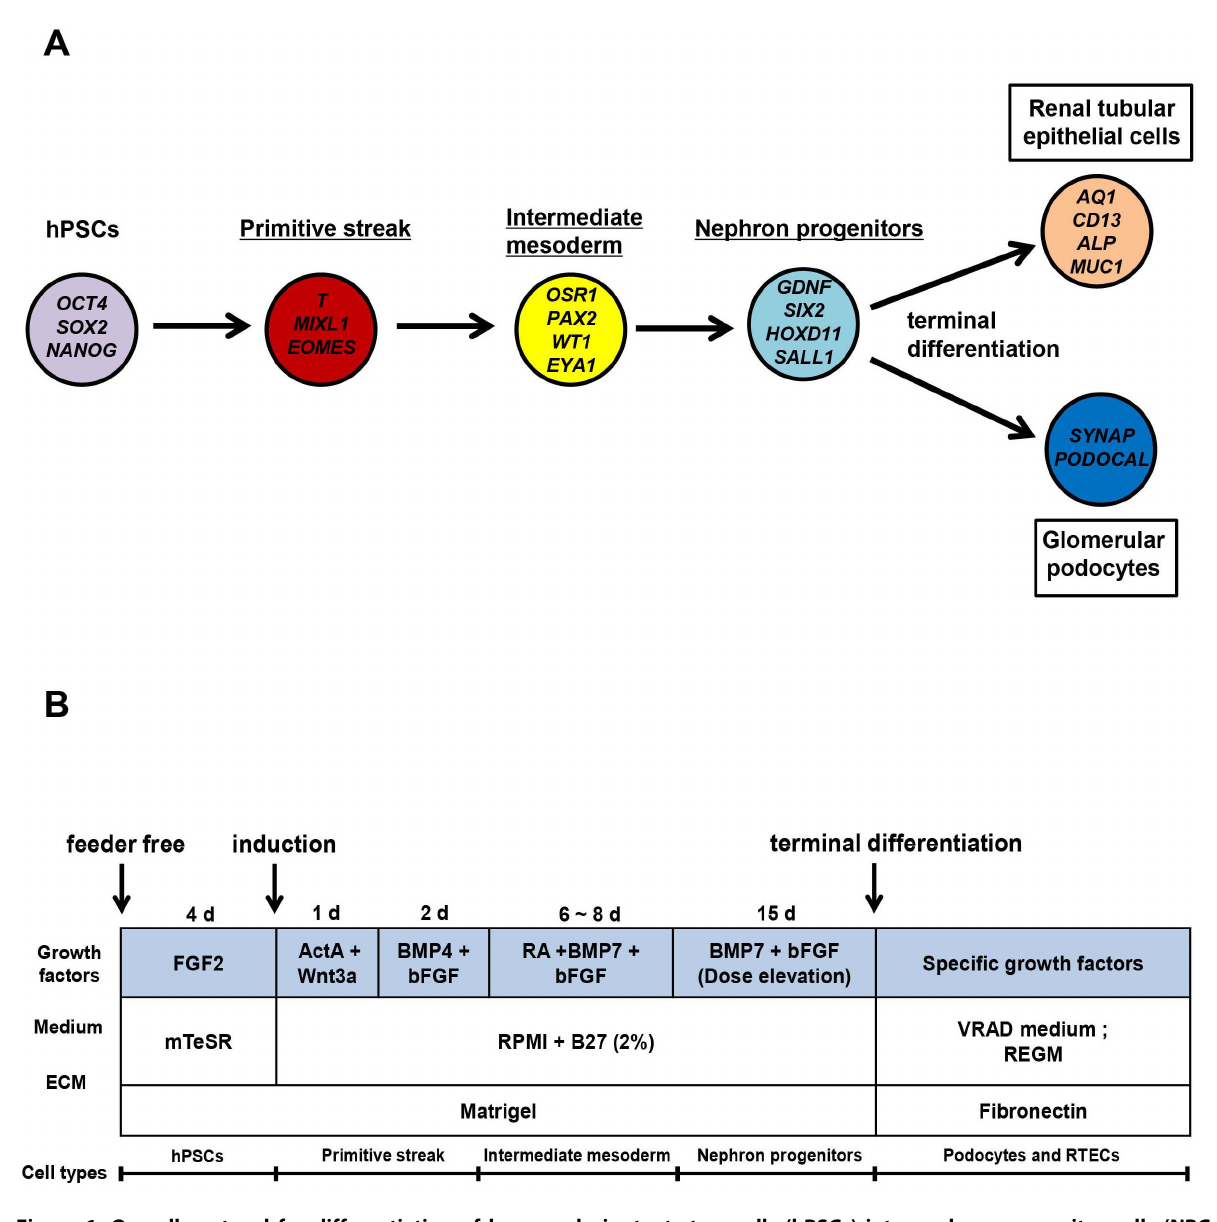
Figure 1. Overall protocol for differentiation of human pluripotent stem cells (hPSCs) into nephron progenitor cells (NPCs). A. Illustration of developmental stage-specific marker genes during differentiation of NPCs and NPC-derived fully differentiated renal epithelial cells. B. Detailed procedures for hPSCs differentiation into NPCs and its derivatives.